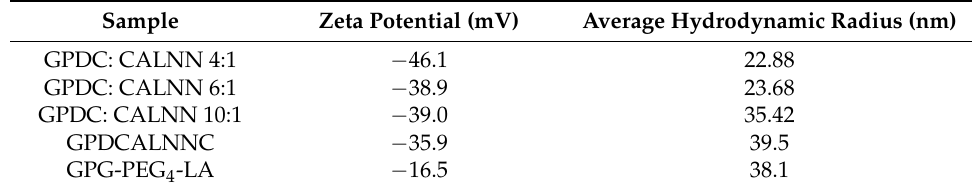
Table 3. Average zeta potential and hydrodynamic radius of different peptide-stabilized Au